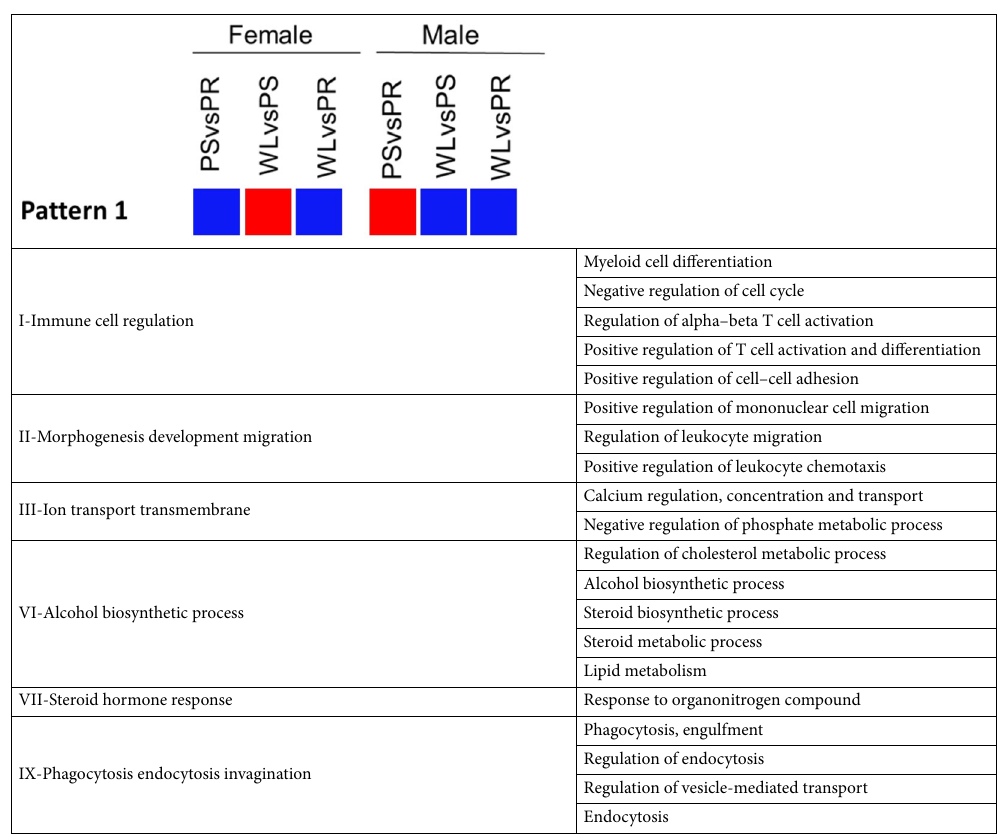
Table 1. Summary of clusters and gene sets included in the pattern 1 for the renal IRI time comparison.